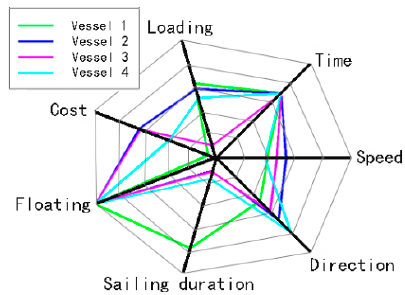
Figure 41. Radar chart of vessel attributes.